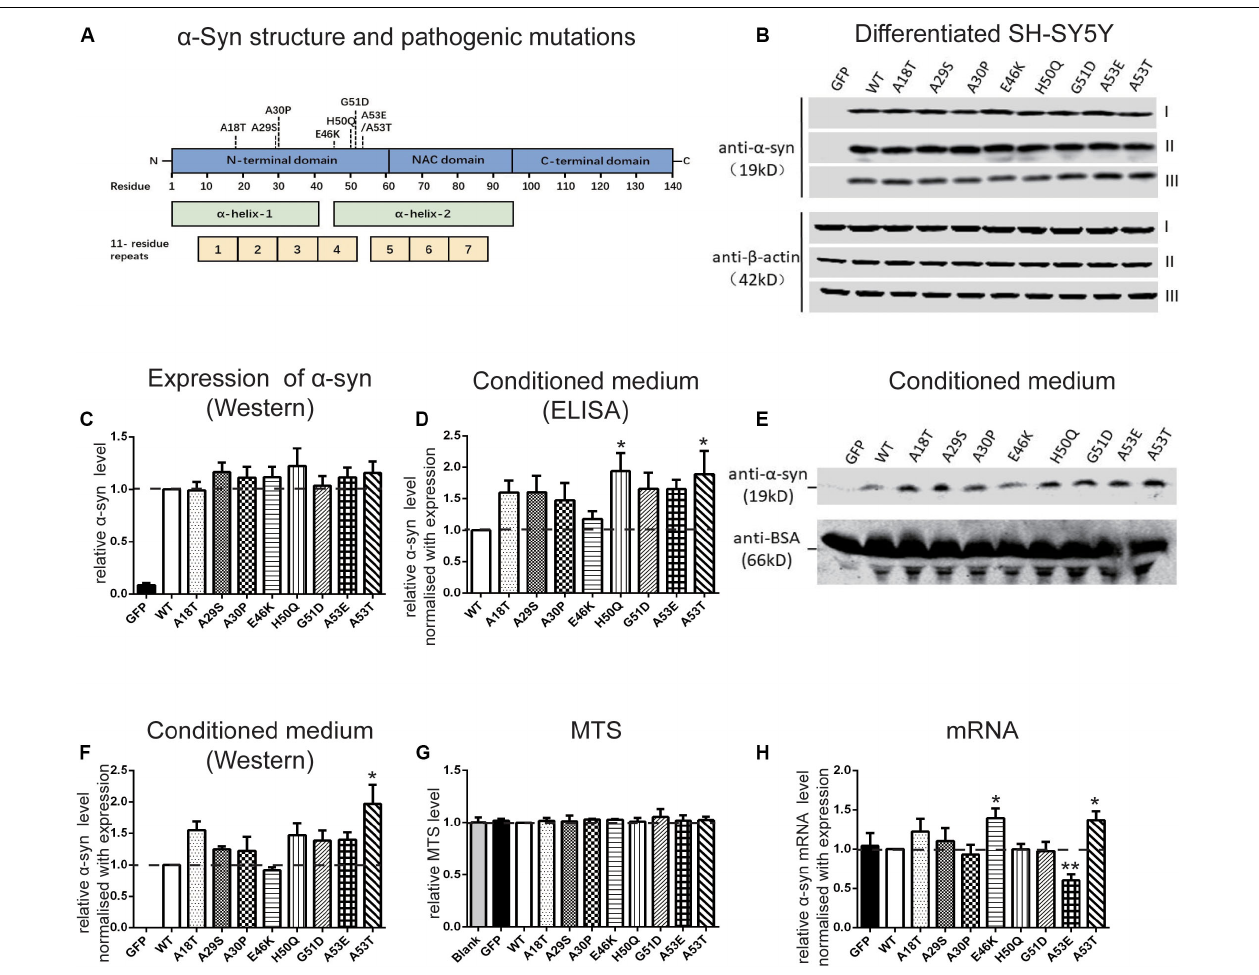
FIGURE 1 | Pathogenic mutations increase α -syn secretion in differentiated SH-SY5Y cells. (A) Schematic of pathogenic mutations of α -syn. (B,C) Immunoblots (B) and analysis (C) of cell lysates ( n = 7 independent cultures, results of three experiments are shown). (D–F) Immunoblots (n = 4 independent cultures) and ELISA analysis ( n = 7 independent cultures) of conditioned medium. (G,H) Normalized MTS levels (G) and mRNA levels quantified by qRT-PCR (H) ( n = 4 independent cultures). Mean ± SEM; * P < 0.05, ** P < 0.01, one-way ANOVA followed by Dunnett’s test compared to